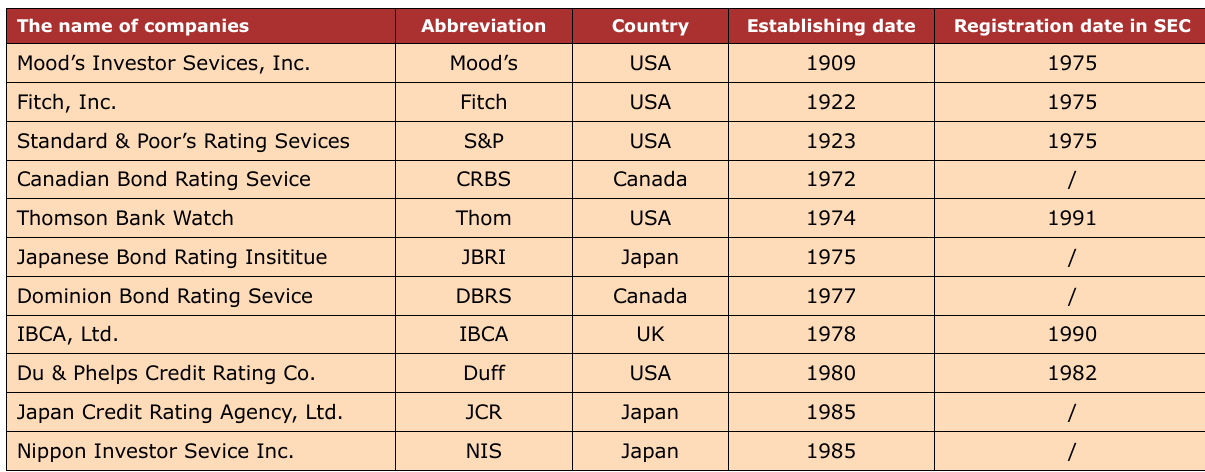
Table 3. The Establishing Date of Major